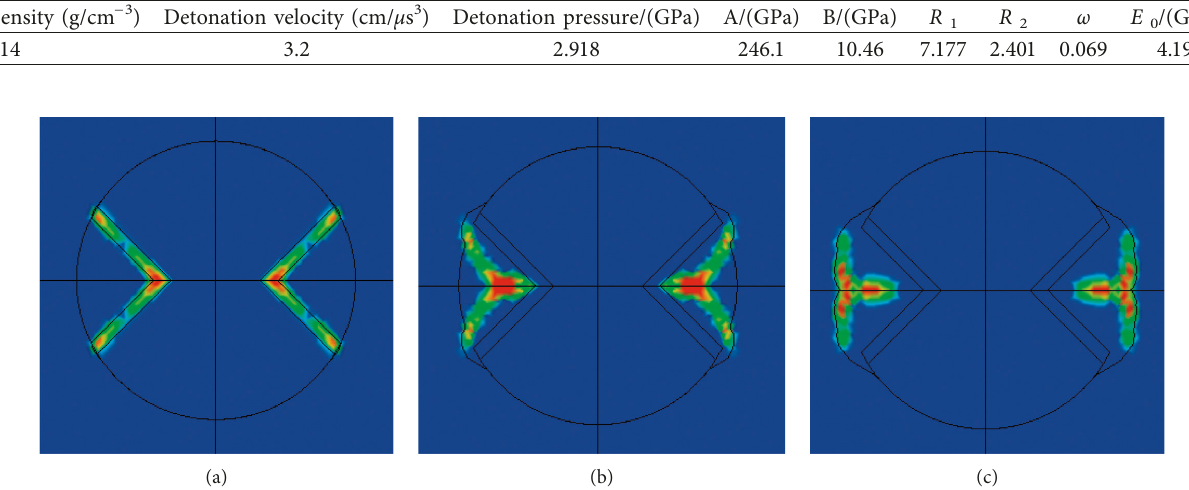
Figure 3: Process of shaped charge jet formation and migration under cumulative blasting with decoupling coefficient 1: (a) t � 3.94 μ s; (b) t � 8.99 μ s; (c) t � 12.99 μ